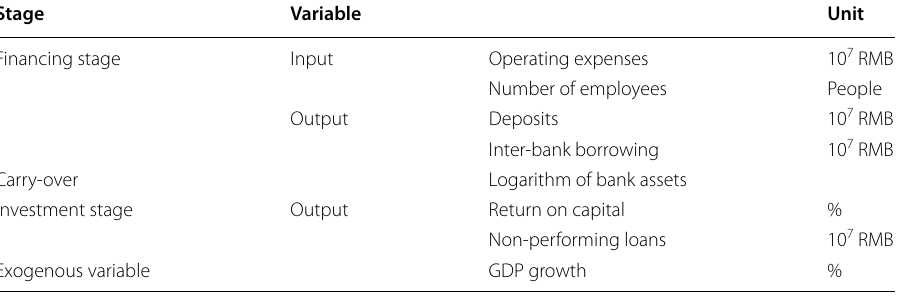
Table 3 Input and output